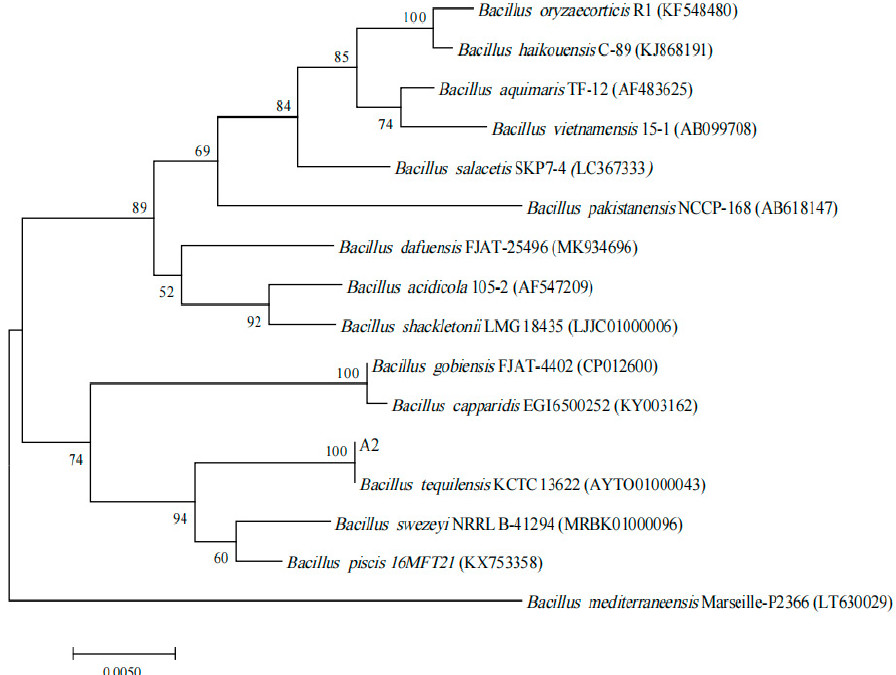
Figure 2. Phylogenetic analysis using 16S rDNA sequences.